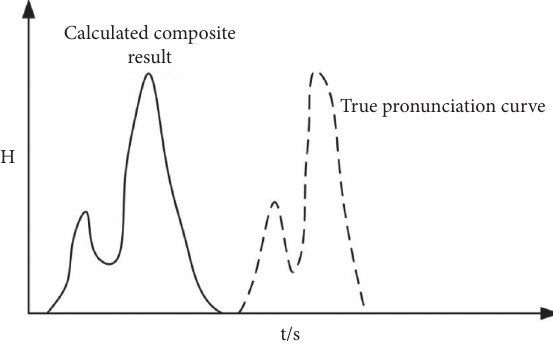
Figure 3: Synthetic result of the syllable flow.